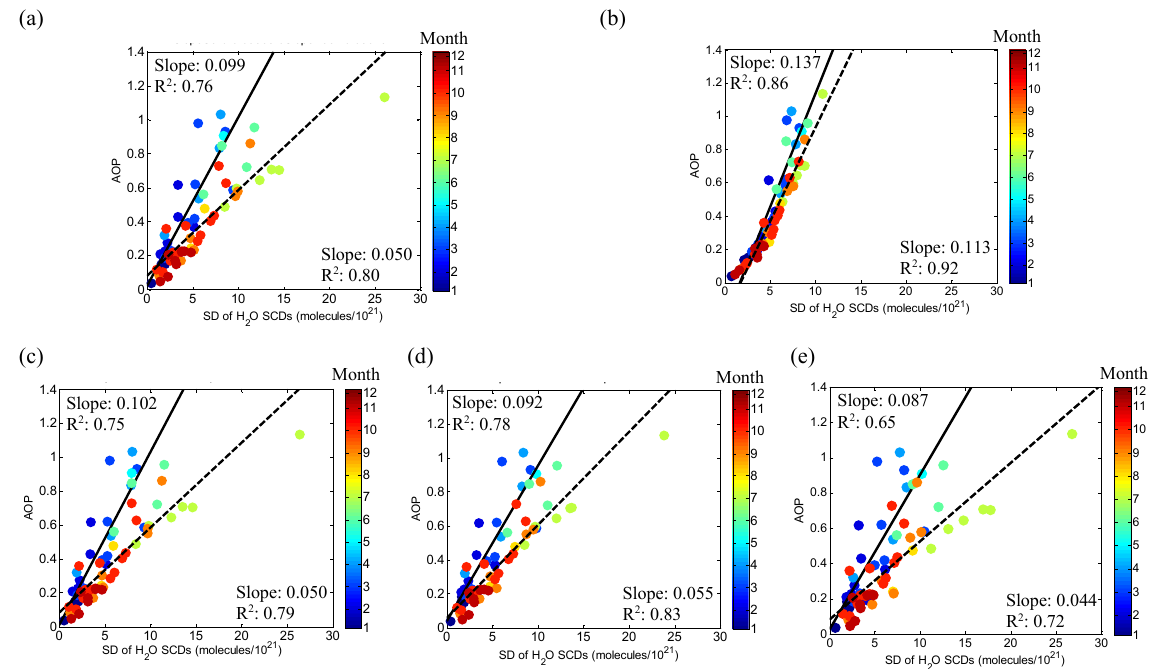
Figure 7. Reproduction of the correlation, as shown in Fig. 4, between daily averaged standard deviation of H 2 O SCDs at noon and the corresponding averaged AOP for two time periods in 2013, using the 2S-ESS RT model. The input AOD data are obtained from AERONET, aerosol compositions are derived from MERRA aerosol reanalysis data, and the related scattering properties, including single scattering albedo (SSA) and asymmetry parameter ( g ), are computed using the GOCART model. The slopes and R 2 from the linear regression for the winter–spring period (solid line) and summer–autumn period (dash line) are shown on the upper-left and bottom-right corners, respectively. Results from five experiments are presented, including (a) the linear correlation reproduced by the 2S-ESS model with averaged AOD data between 12:00 and 14:00LT and compositions for the five composite aerosols (black carbon, organic carbon, sulfate, dust, and sea salt) at 13:00LT, for the 68 days; (b) same as (a) except that the H 2 O SCD truth is fixed for all days at the mean value for the 68 days in 2013, in order to examine the impact from variability in H 2 O abundance; (c) same as (a) except that the SSA is fixed for all days at the mean value for the 68 days in 2013, in order to examine the impact from SSA variations; (d) same as (a) except that g is fixed for all days at the mean value for the 68 days in 2013, in order to examine the impact from g variations; (e) same as (a) except that g for each of the 68 days is set at half of the original value, in order to examine its contribution to the linear